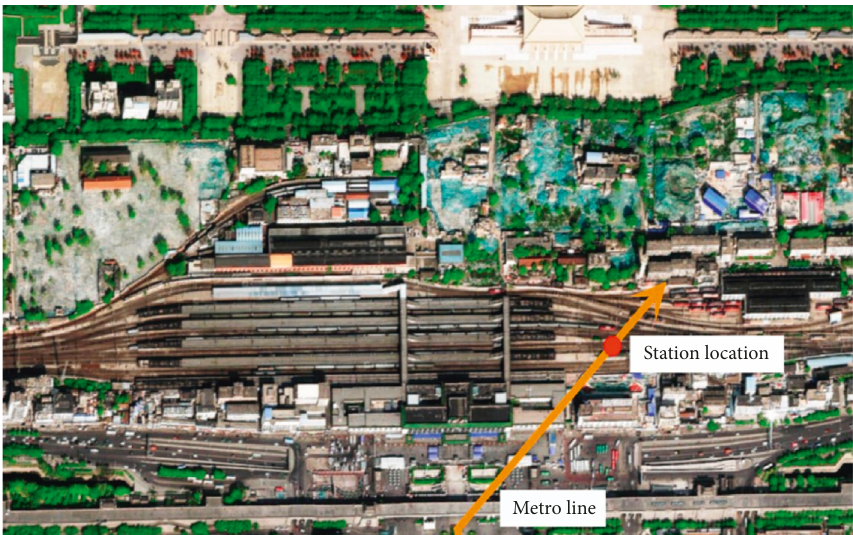
Figure 1: Schematic of Xi’an Metro Line 4 tunnel running under the railway station.